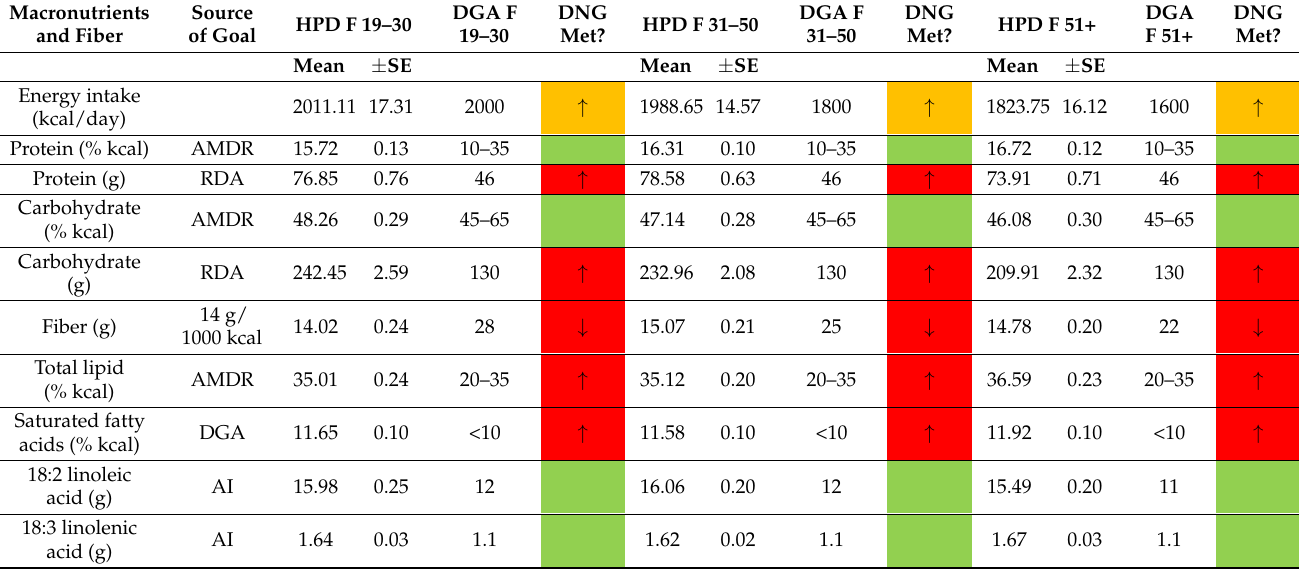
Table 5. Macronutrient and fiber intake in females following an HPD compared to the DNG in the 2020–2025 DGA stratified by age